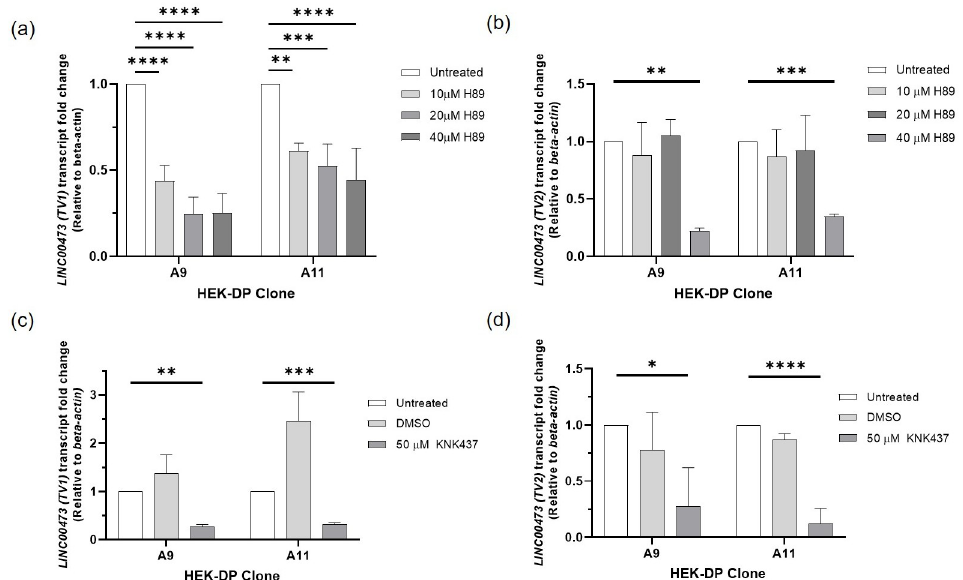
Fig 5. Pharmacologic targeting of PKA with H89 and Hsp40 with KNK437 results in downregulation of LINC00473 in HEK-DP cells. (a) H89 treatment of A9 and A11 clones demonstrates decreased expression of LINC00473 (TV1) ; (b) H89 treatment of A9 and A11 clones demonstrates decreased expression of LINC00473 (TV2); (c-d) KNK437 treatment results in decreased expression of LINC00473 TV1 and TV2 . ( � p < 0.05; �� p < 0.01; ��� p < 0.001; ���� p < 0.0001).